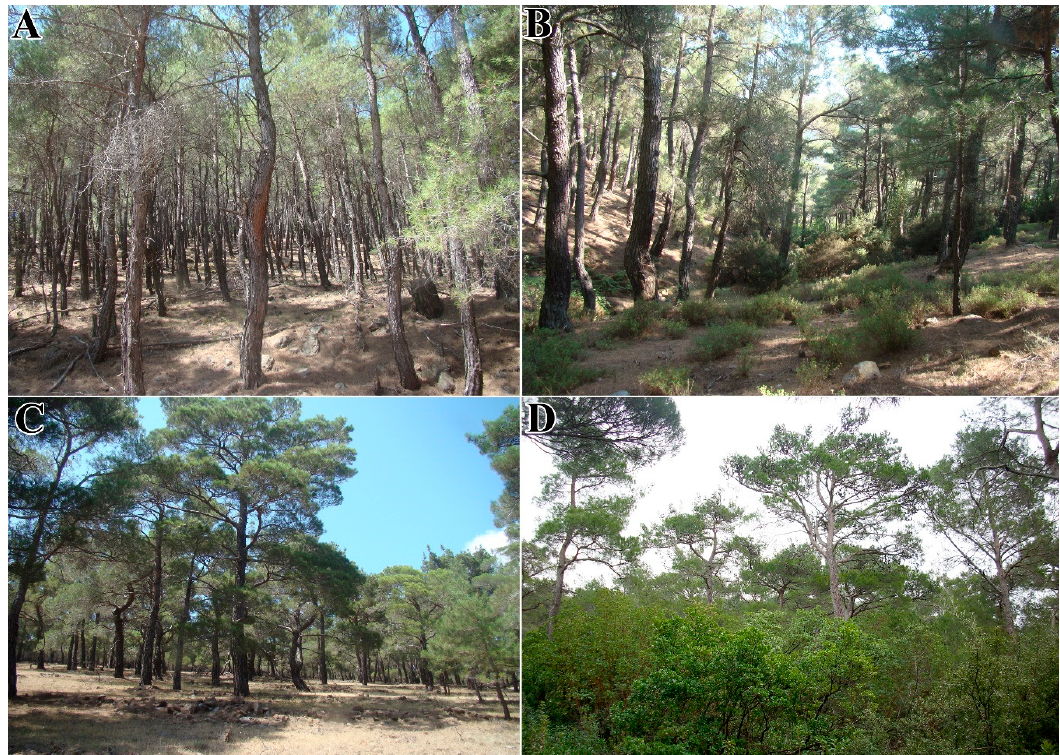
Figure 3. The typology of the four types of dense pine forests: ( A ) litter understory; ( B ) short shrub understory with litter; ( C ) low-fuel understory; ( D ) tall shrub understory with litter (photos by the